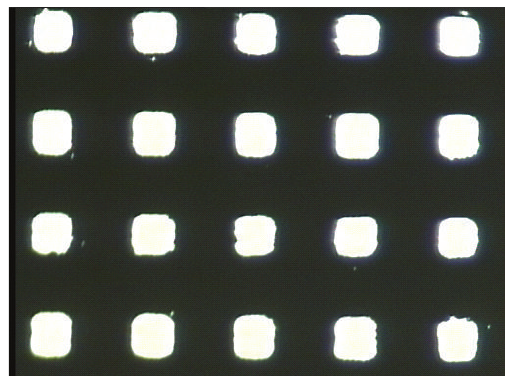
Figure 8: Optical micrograph of the Cr layer after etching. Figure 9: Surface profile of the Cr layer after etching.